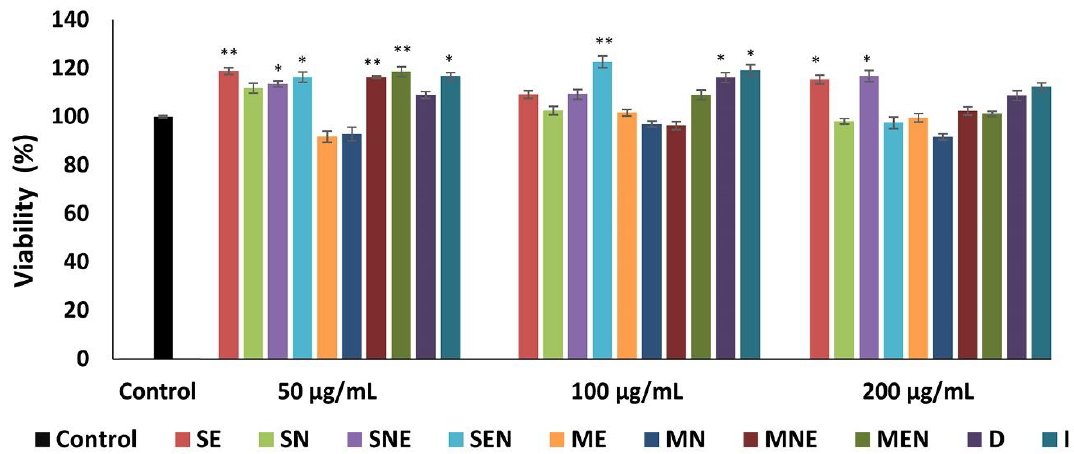
Figure 2. Proliferation of fibroblasts (%) treated with different concentrations (50, 100, 200 µg/mL) of TS extracts by MTT assay. Untreated fibroblasts were used as control. Data were presented as mean ± SEM (n = 3) and compared with the control group, * p < 0.05, ** p < 0.01. SE — Soxhlet ethanol, SN —